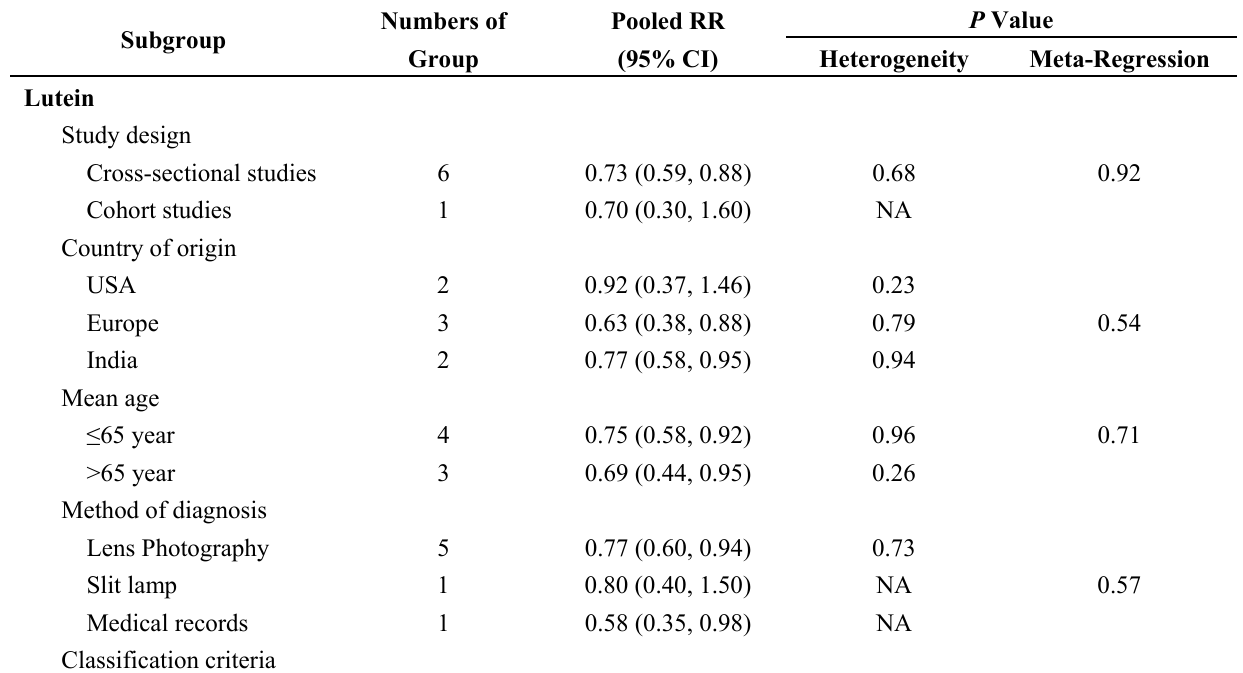
Table 2. Stratified analysis of the association between serum level of lutein and zeaxanthin and nuclear